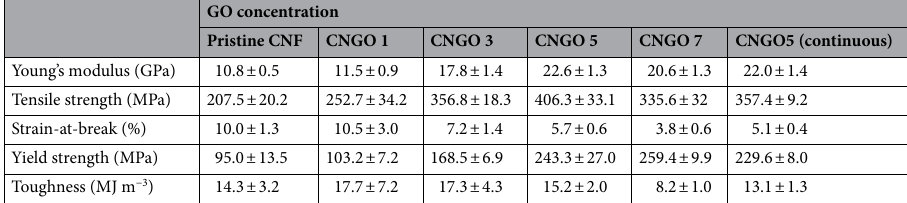
Table 1. Tensile test results.